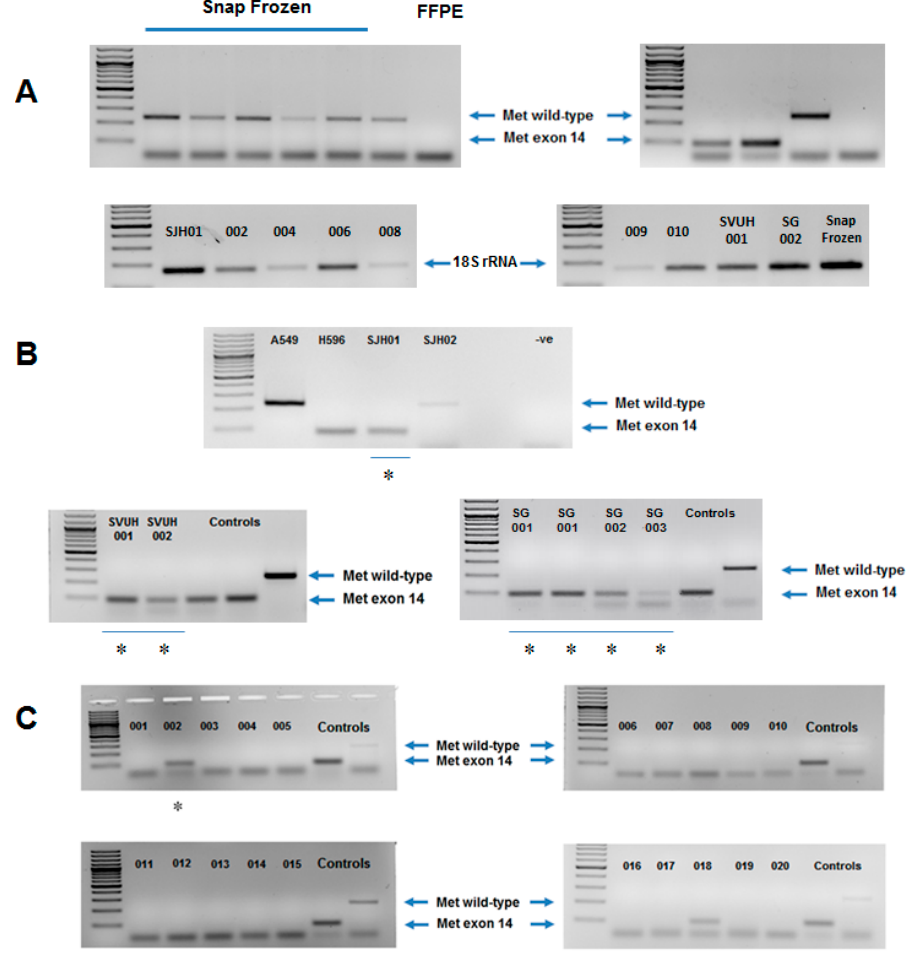
Figure 1. End ‐ point PCR detection of METex14 in three cohorts of non ‐ small cell lung cancer (NSCLC) formalin ‐ fixed paraffin ‐ embedded (FFPE). ( A ) Amplification of the Wild ‐ Type amplicon